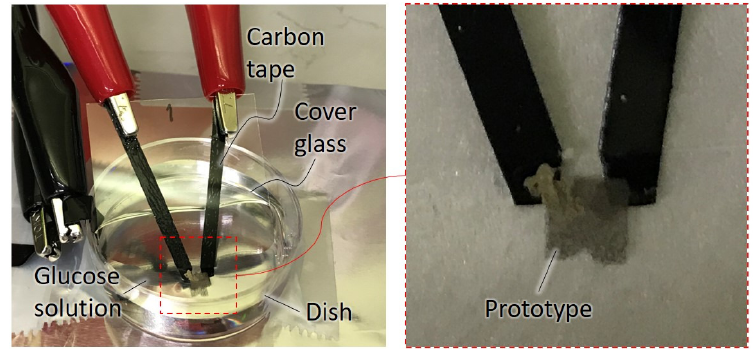
Figure 6. Experimental setup to measure OCP of a prototype in glucose solution.